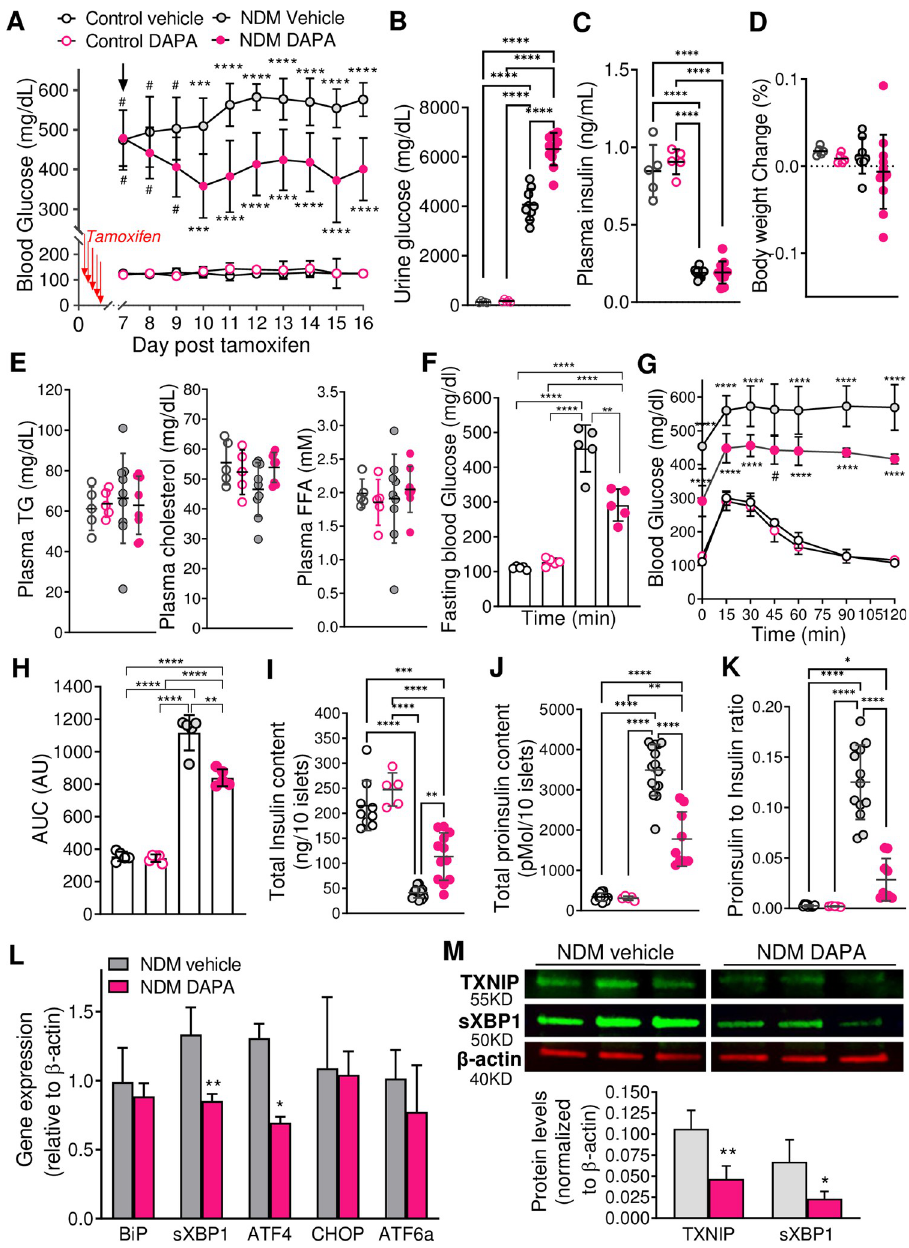
Fig 4. Dapagliflozin therapy in NDM mice improves β -cell function though reduction of oxidative and ER stress (A) Blood glucose in control and NDM mice administered with vehicle or dapagliflozin (DAPA) by daily oral gavage on day 7 post-tamoxifen (n = 5–15 mice/group). (B) Urine glucose (C) Plasma insulin and (D) % body weight change after 10 days of vehicle or DAPA treatment (n = 5–11 mice/group). (E) Plasma lipid panel (TG, cholesterol and FFA) (n = 5–9 mice/group). Fasting blood glucose (F), glucose tolerance test (G) and calculated area under the curve (AUC, H) from control and NDM mice after 10-day treatment with vehicle or DAPA (n = 5 mice/group). (I) Islet total insulin content, (J) Total proinsulin content and (K) Proinsulin:insulin ratio (n = 5–12 mice/group). (L) Quantitative real- time PCR analysis of gene expression of ER stress markers in islets after 10 days treatment with DAPA or vehicle (n = 4 mice/group). (M) Western blot analysis on isolated islets after 10 days treatment with DAPA or vehicle, representative blot (top) and quantification (bottom) of TXNIP and sXBP1 (n = 4–6 mice/group). Black open circles: control vehicle, pink open circles: control DAPA, grey filled circles and grey bars: NDM vehicle treated, and pink filled circles and pink bars: NDM DAPA treated mice. Arrow indicates initiation of DAPA therapy. Data are expressed as mean ± SD � P < 0.05, �� P < 0.01, ��� P < 0.001, ���� P < 0.001 (For Fig 4A significance of ��� P < 0.001, ���� P < 0.001 respect to all other three groups, and # p < 0.0001 respect to control vehicle and control DAPA only).